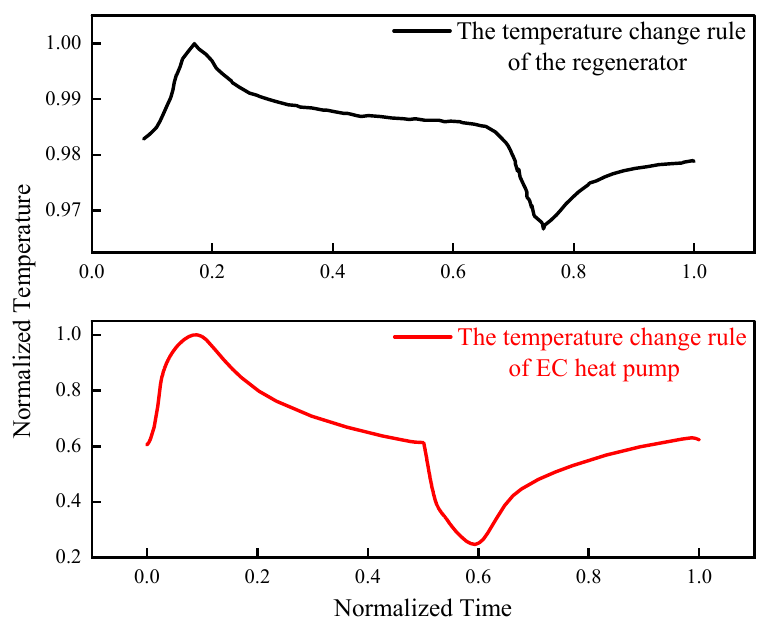
Figure 7. The verification of the numerical Figure 7. The veri fi cation of the numerical model.